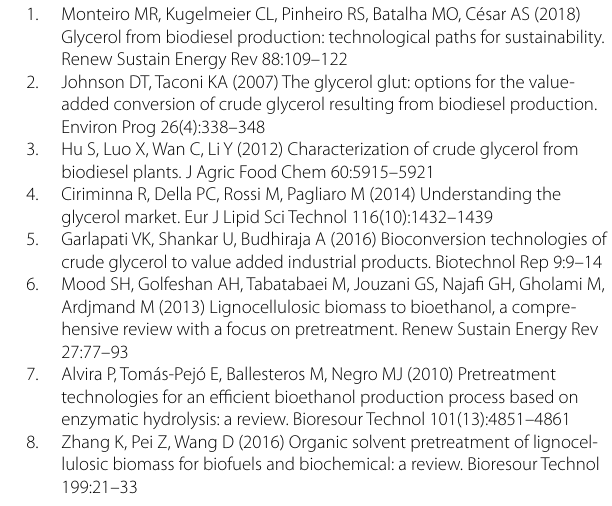
Viscosity could not be measured because of solid state at 40 °C ND not